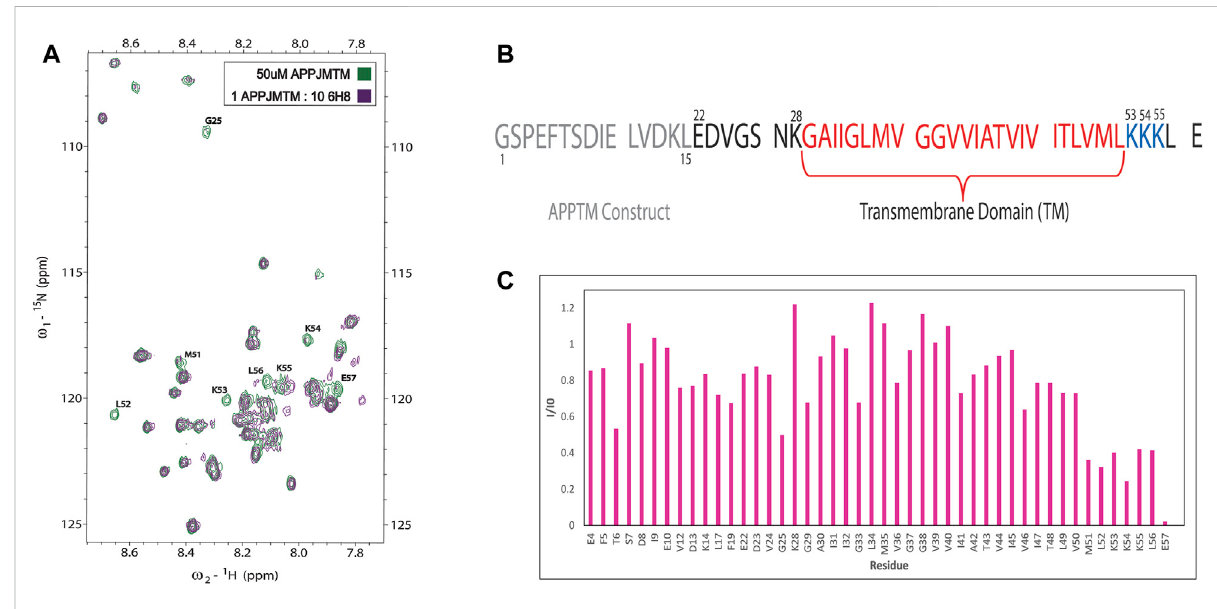
FIGURE 3 NMR of titration of APPTM with covalent fragment 6H8. (A) n overlay of 2D 1 H- 15 N TROSY spectrum of APPTM with (green) and without 6H8 (purple). Resonances with the largest changes in peak intensity were labeled by residue type and number. (B) Sequence of APPTM construct used in all experiments. Residue numbering switches to A β numbering at residue E22 (C). Selective line broadening observed in 3A is quanti fi ed via I/I 0 calculation, where the peakheight at each residueof theAPO spectrum (green) isI 0 and thepeak height per residue oftitration point (purple)is (I). Substantial line broadening is observed at and near the C-terminal triple Lys motif indicated by a low (under 0.5) I/I 0